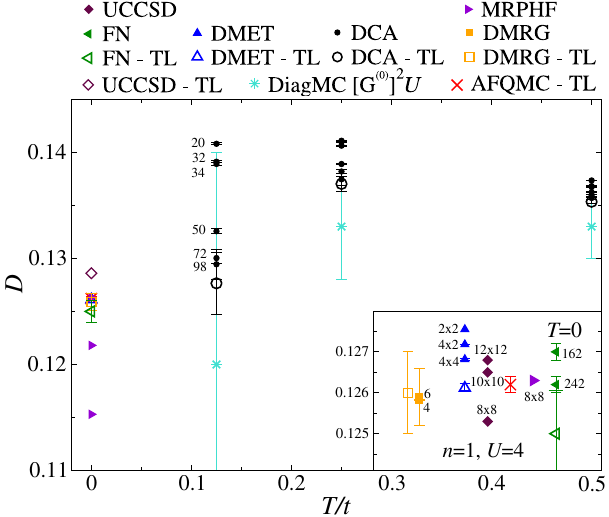
FIG. 10. Data for n ¼ 1 for U=t ¼ 4 . Main panel: Temperature dependence of double occupancy D , compiled from various techniques. Solid symbols represent finite systems; open symbols represent extrapolations to the thermodynamic limit. Finite- T results are shown for DCA and DiagMC (turquoise stars), and zero- T data from DMET (blue triangles), UCCSD (maroon diamonds), MRPHF (purple triangles), DMRG (orange squares), and FN (green triangles). Inset: Zoom-in of the zero- T data from DMRG, FN, UCCSD (only finite-system data), DMET, and